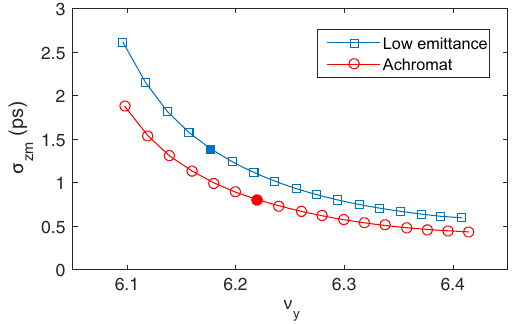
FIG. 3. Bunch length (top) and vertical eigenemittance (bot- tom) from numeric Ohmi envelope calculation is compared to formulas [Eq. (70) for bunch length and Eq. (77) for vertical eigenemittance].